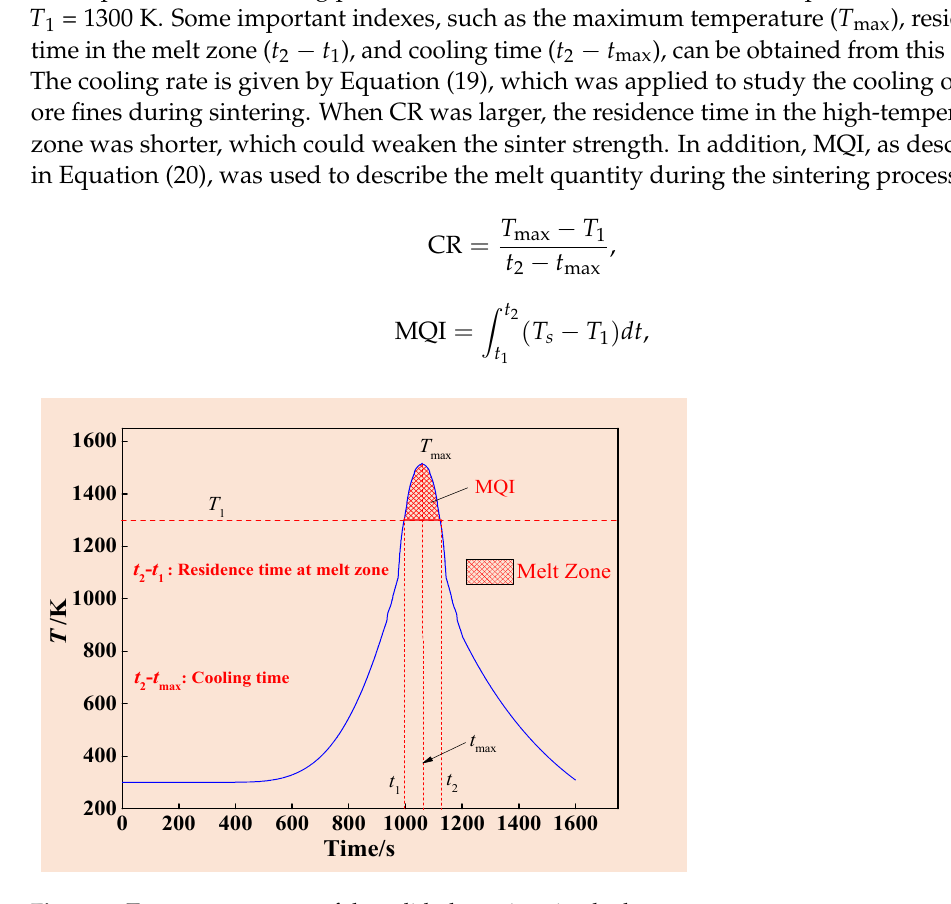
Figure 7. Temperature curve of the solid phase sintering bed.